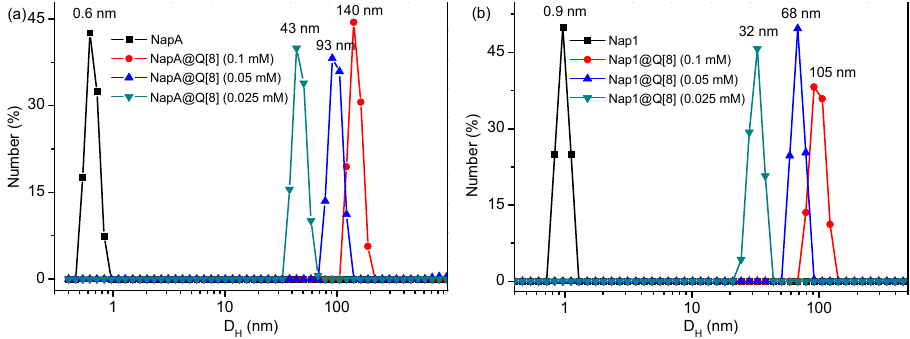
Figure 4. DLS profile of ( a ) NapA 2 @Q[8] and ( b ) Nap1 2 @Q[8] in water at 25 °C. The concentration represents that of NapA or Nap1 of homoternary complexes.